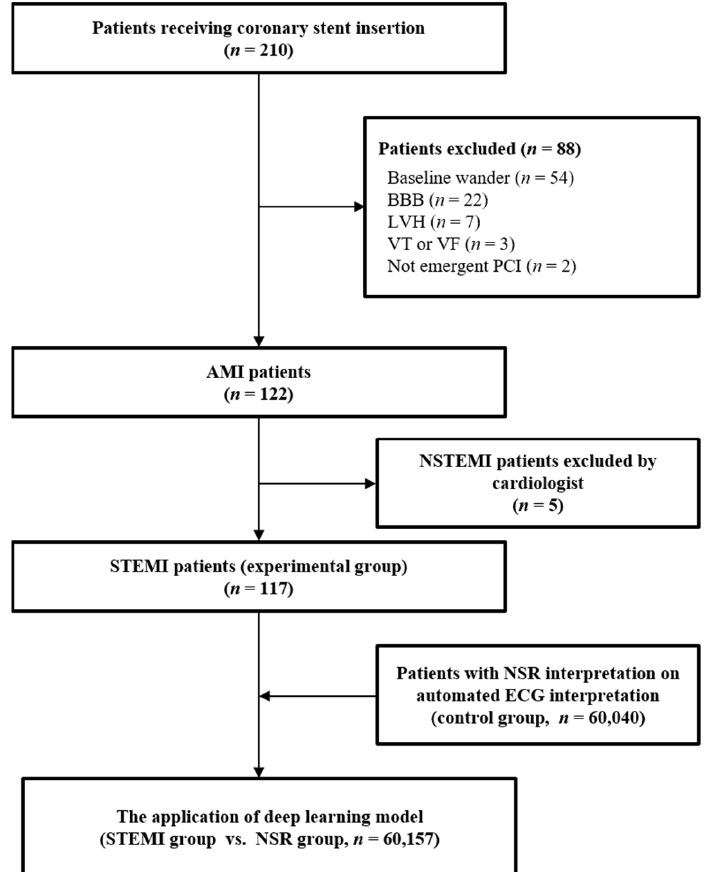
Figure 2. Flow diagram for this study. The patients having the ECG interpretation of “normal sinus rhythm and normal ECG” were included in the NSR group. BBB, bundle branch block; LVH, left ventricular hypertrophy; VT, ventricular tachycardia; VF, ventricular fibrillation; PCI, percutaneous coronary intervention; AMI, acute myocardial infarction; NSTEMI, non-ST elevation myocardial in- farction; STEMI, ST elevation myocardial infarction; NSR, normal sinus rhythm; ECG, electrocardiogram. Table 1. Baseline characteristics of the experimental